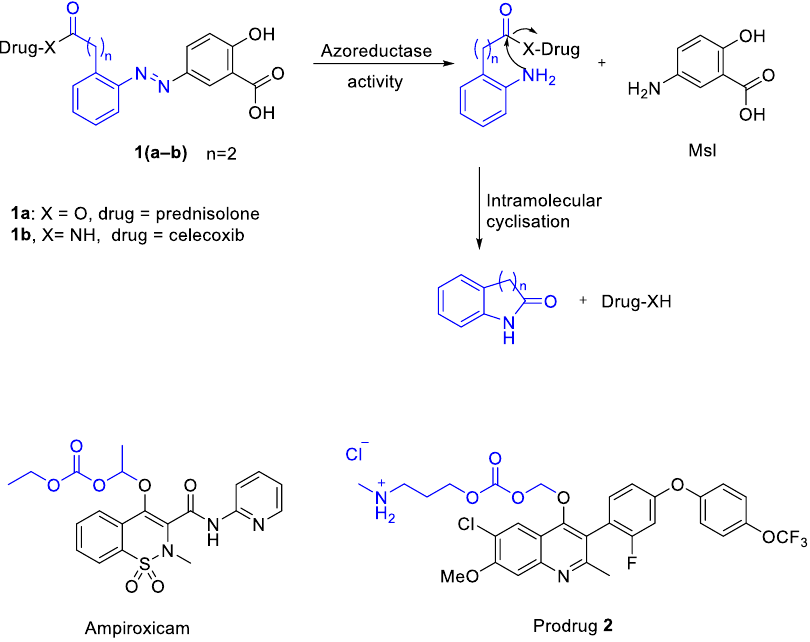
Figure 1. ( a ) Azoreductase-cyclisation activation mechanism of prodrugs 1(a–b) , ( b ) structure of Figure 1 . ( a ) Azoreductase-cyclisation activation mechanism of prodrugs 1(a – b) , ( b ) structure of ampiroxicam and prodrug 2. ampiroxicam and prodrug 2